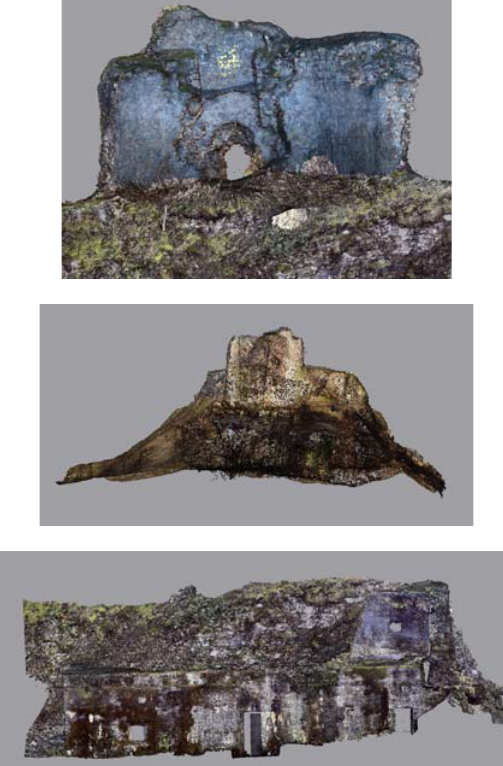
Figure 6 : Different renderings of characteristic places.